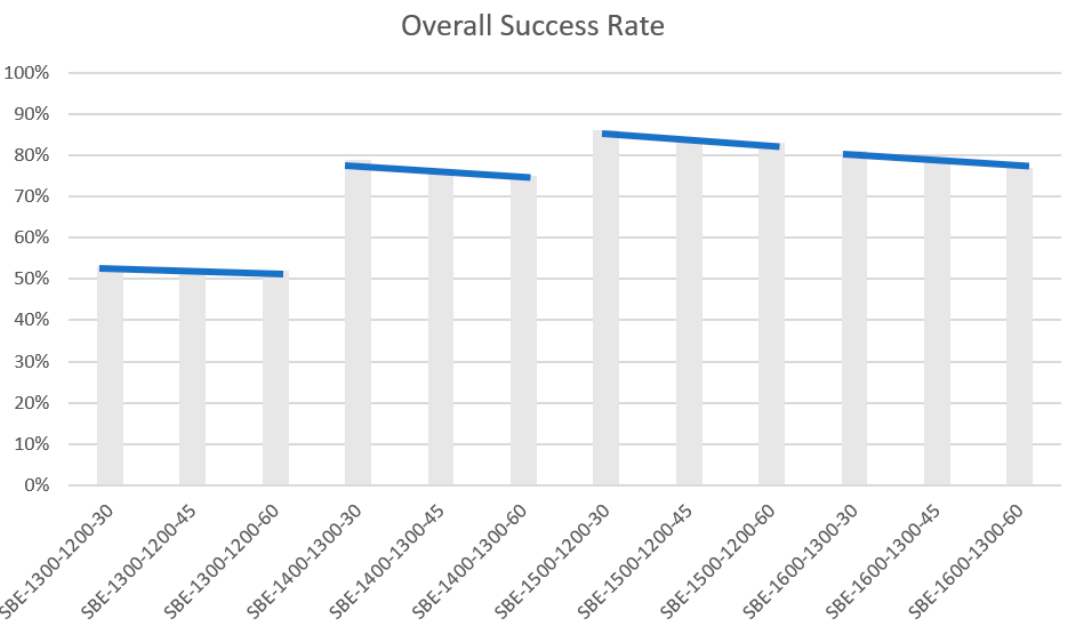
Figure 5. The overall success rate for the SBE strategy at each of the elevations, for different evaluation widths. Each blue line represents performance at a particular elevation. At each depth, performance falls as evaluation width increases. OSR = Overall success rate =100 × (GDIR_success_num + nonGDIR_success_num)/NTest .